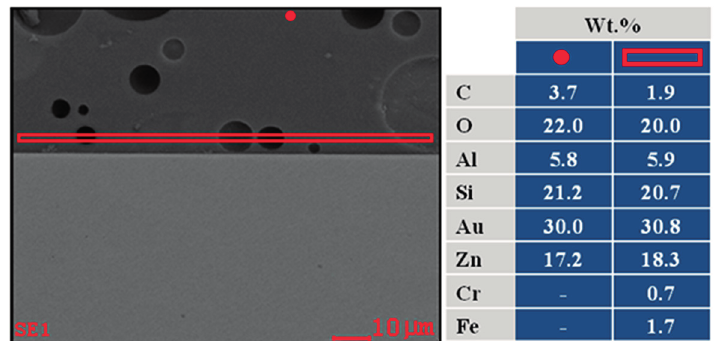
Figure 7. FE - SEM micrograph of the cross section of ZnO15 coating on stainless steel alloy in air ( on the left ); and energy dispersive spectrometry (EDS) analysis of the selected area ( on the right ). The areas selected were one close to the interface ( red rectangle ) and the other far away from it ( red point ).